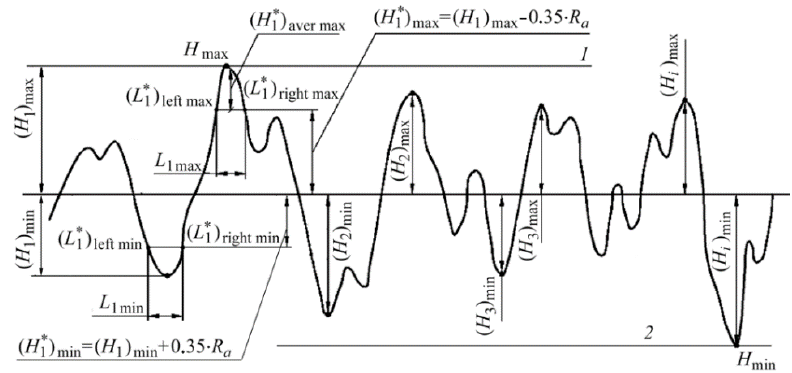
Figure 1. Profile of the surface of the samples of steel 20: 1—line of projections; 2—line of troughs.